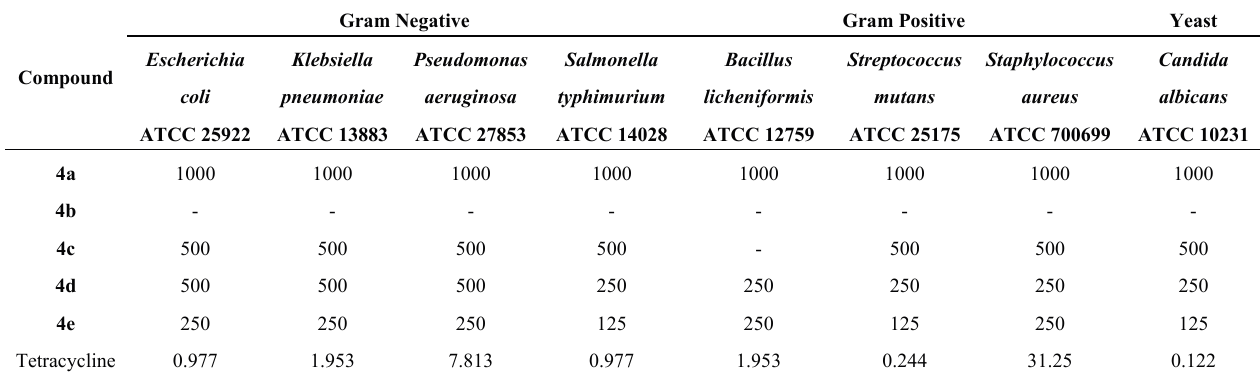
Table 3. Minimum inhibition concentration (MIC) of the synthesized